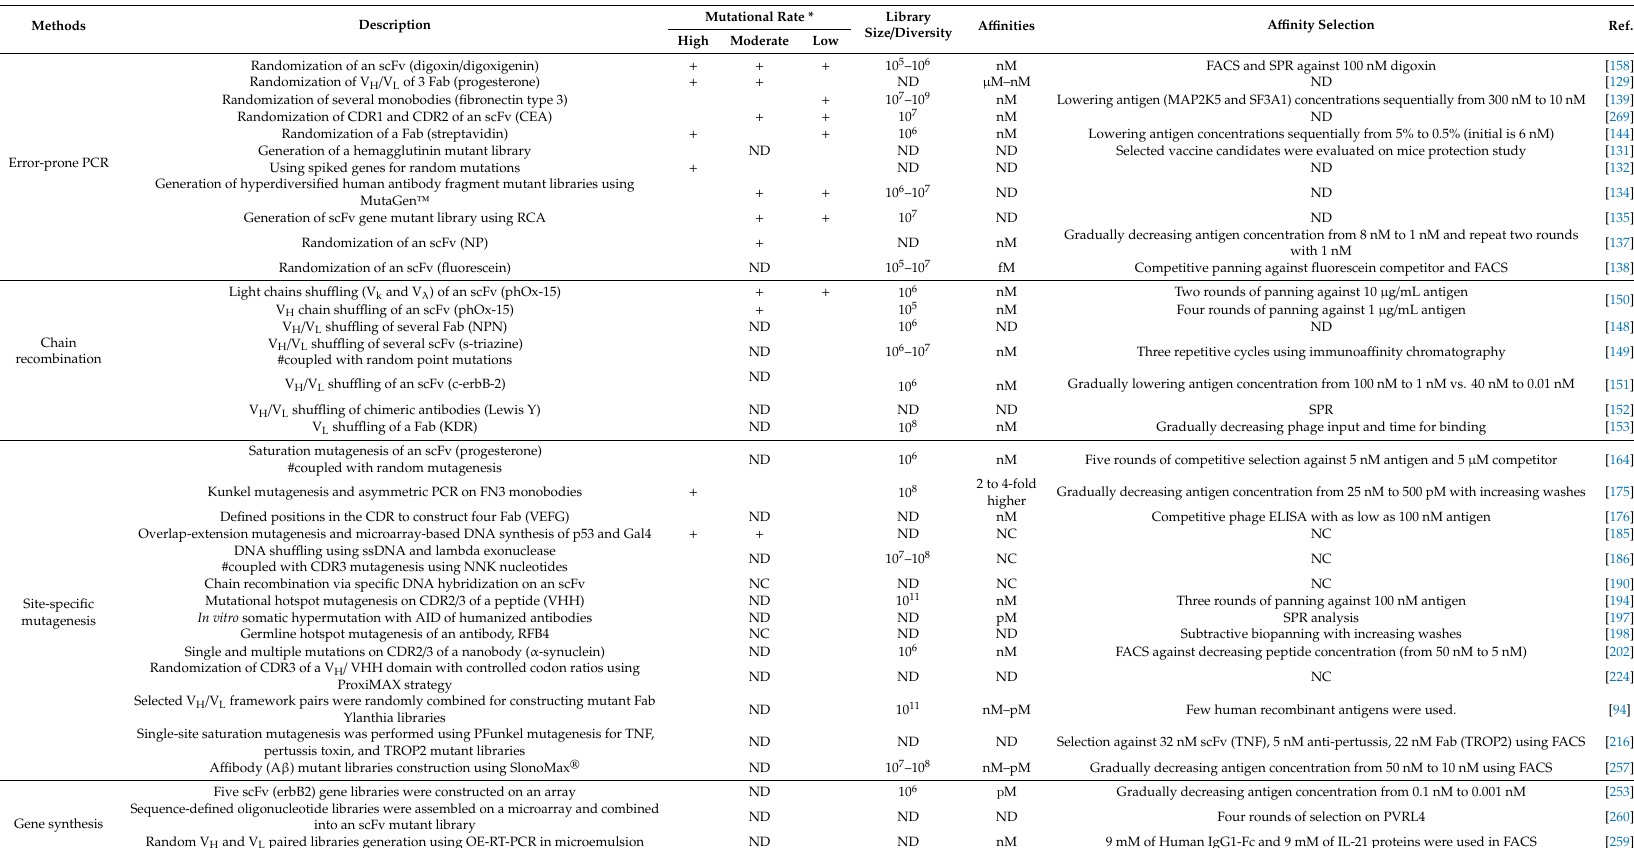
PCR: Polymerase chain reaction; scFv: Single-chain variable fragment; FACS: Fluorescence-activated cell soring; SPR: Surface plasmon resonance; Fab: Antigen-binding fragment; ND: Not determined; MAP2K5: mitogen-activated protein kinase kinase 5; SF3A1: Splicing factor 3A subunit 1; CDR: Complementarity determining region; CEA: Carcinoembryonic antigen; RCA: Rolling circle amplification; NP: 4-hydroxy-3-nitrophenyl acetyl; phOx: 2-phenyloxazolone; NPN: Nitrophenyl phosphonamidite; c-erbB-2: Glycoprotein tumour antigen; Lewis Y: Carbohydrate epitope; KDR: Kinase inserting domain-containing receptor; NC: Not applicable; VEGF: Vascular epithelial growth factor; p53: Human tumour suppressor; Gal4: Yeast transcription factor; VHH: Heavy chain variable domain antibody or nanobody; RFB4: Anti-CD22 monoclonal antibody; SDR: Specificity determining residues; TNF: Tumour necrosis factor; TROP2: Tumour-associated calcium signal transducer 2; A β : Amyloid beta; PVRL4: Poliovirus receptor-related 4; OE-RT-PCR: Overlapping extension real-time polymerase chain reaction. * Mutational rate ranking is an approximation according to the listed articles. Many articles do not determine mutational